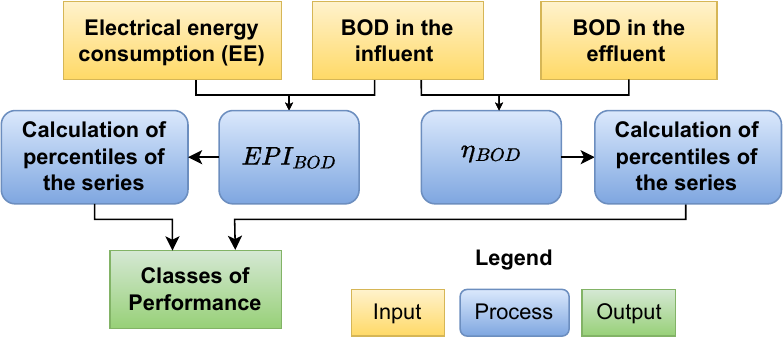
Figure 4. Diagram illustrating the proposed procedure in